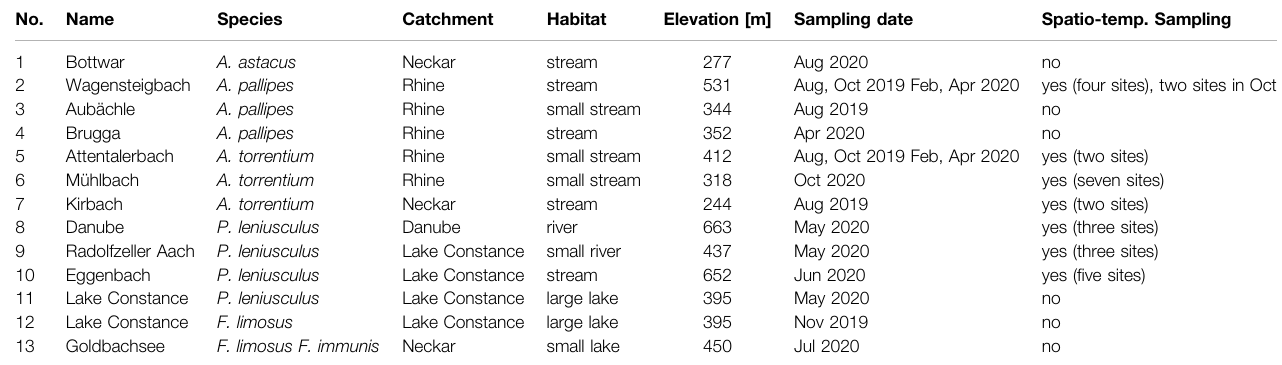
TABLE 2 | Overview of the investigated water bodies with information on the target species, name and catchment of water body, habitat characteristics, sampling date and sampling method. No. Name Species Catchment Habitat Elevation [m] Sampling date Spatio-temp.